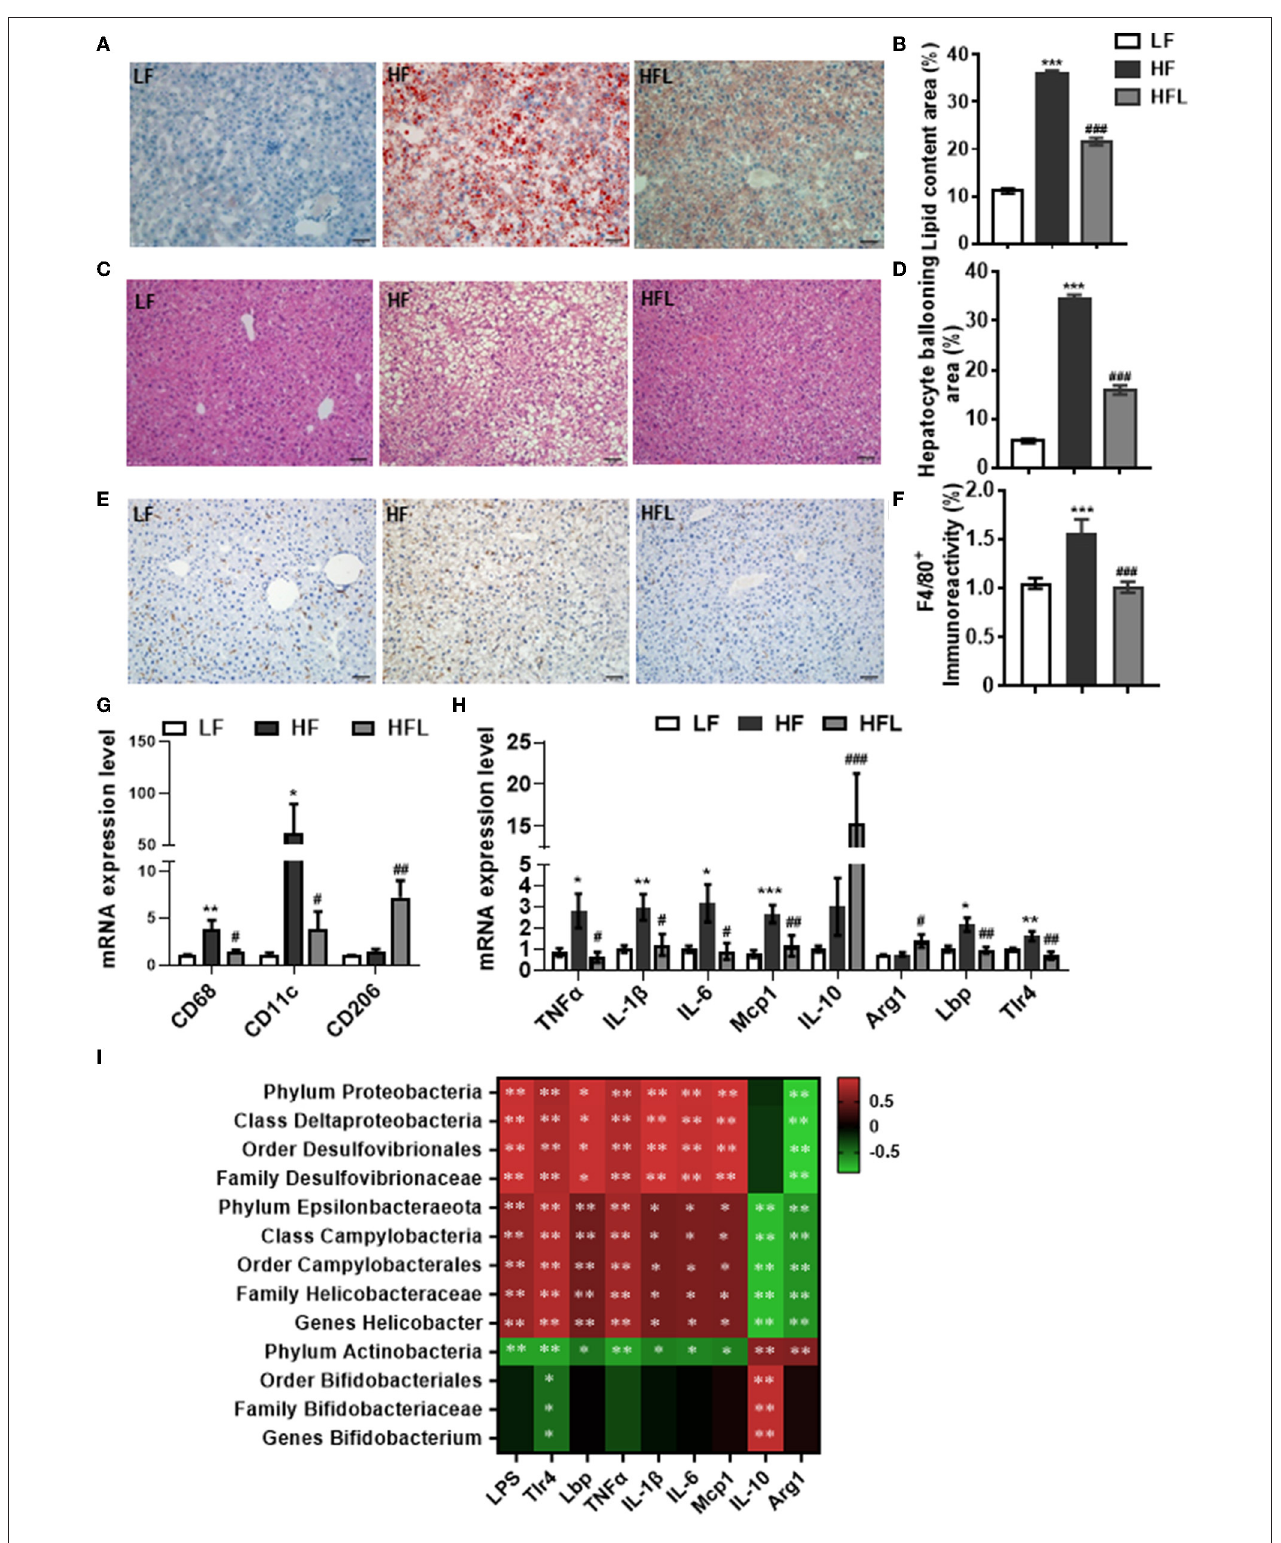
FIGURE 4 | Lentinan prevented HF diet-induced hepatic lipid deposition, macrophage infiltration, and hepatic inflammation. (A) Oil red O staining of liver sections. (B) Quantification of hepatic lipid area after Oil red O staining. (C) H&E staining of liver sections. (D) Quantification of hepatic ballooning after H&E staining. (E) F4/80 protein staining of liver sections. (F) Densitometric analysis of F4/80 staining. (G) CD68, CD11c, and CD206 mRNA levels in liver tissues of mice. (H) The mRNA levels